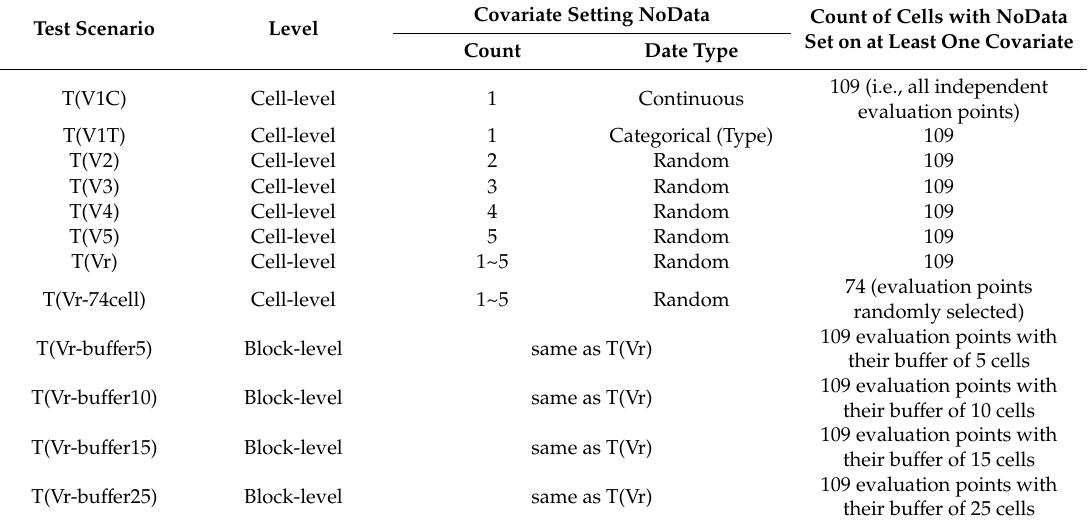
Table 2. Test scenarios with NoData value randomly set for one or several of the five environmental covariates at the cell level and the block level,